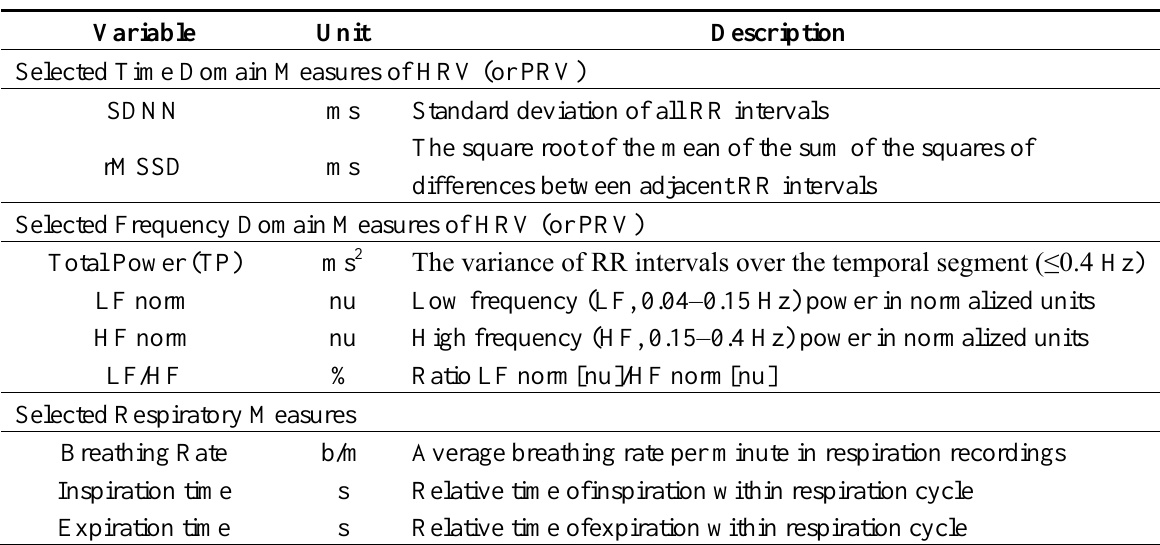
Table 2. HRV and respiration variables in our software system for stress assessment and biofeedback application